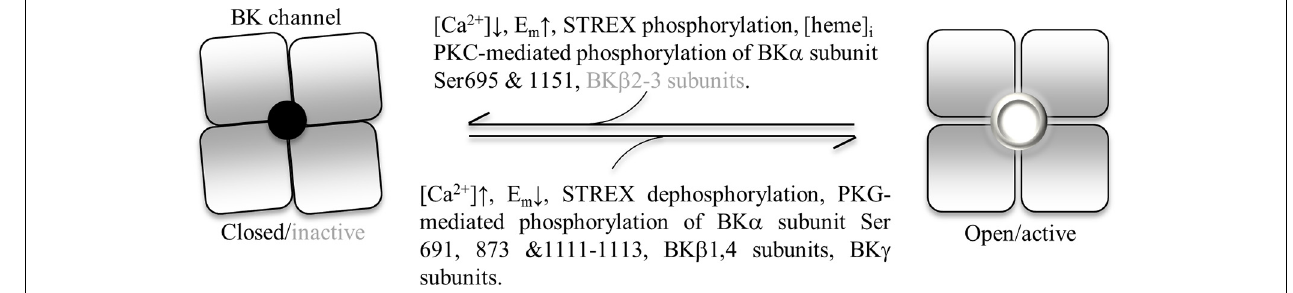
FIGURE 3 | A summary of cellular events/factors leading to BK channel activation (open pore) and deactivation/inactivation (closed pore). Abbreviations: E m , membrane potential; STREX, stress-axis regulated exon; PKC, protein kinase C; Ser,